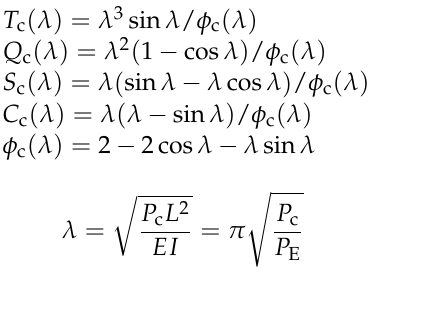
where E denotes the elastic modulus; A denotes the cross-sectional area; I denotes the cross-sectional moment of inertia; L denotes the element length; and T c , Q c , S c , and C c are coefficients in the element stiffness matrix as functions of factor λ , formulated as Equation (4); λ (in a flexural-axial problem) denotes a dimensionless factor for the axial compression force P c , defined as Equation